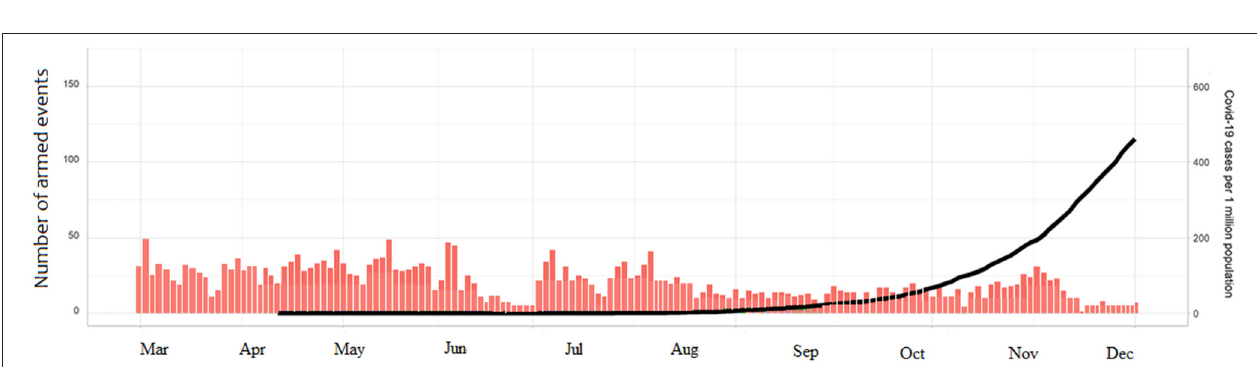
FIGURE 8 | Levels of violence and COVID-19 cases in Yemen during